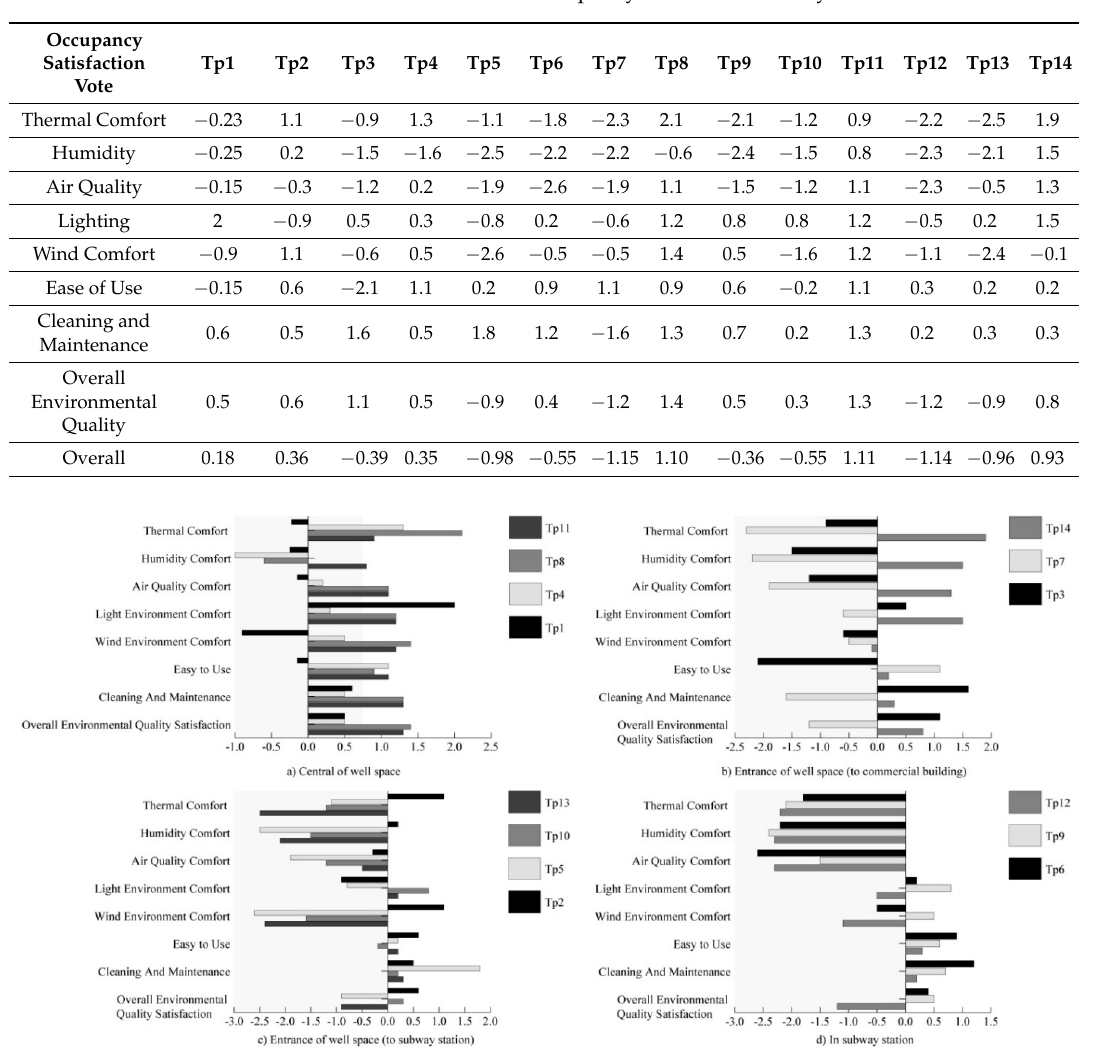
Table 11. Results data from occupancy satisfaction survey.